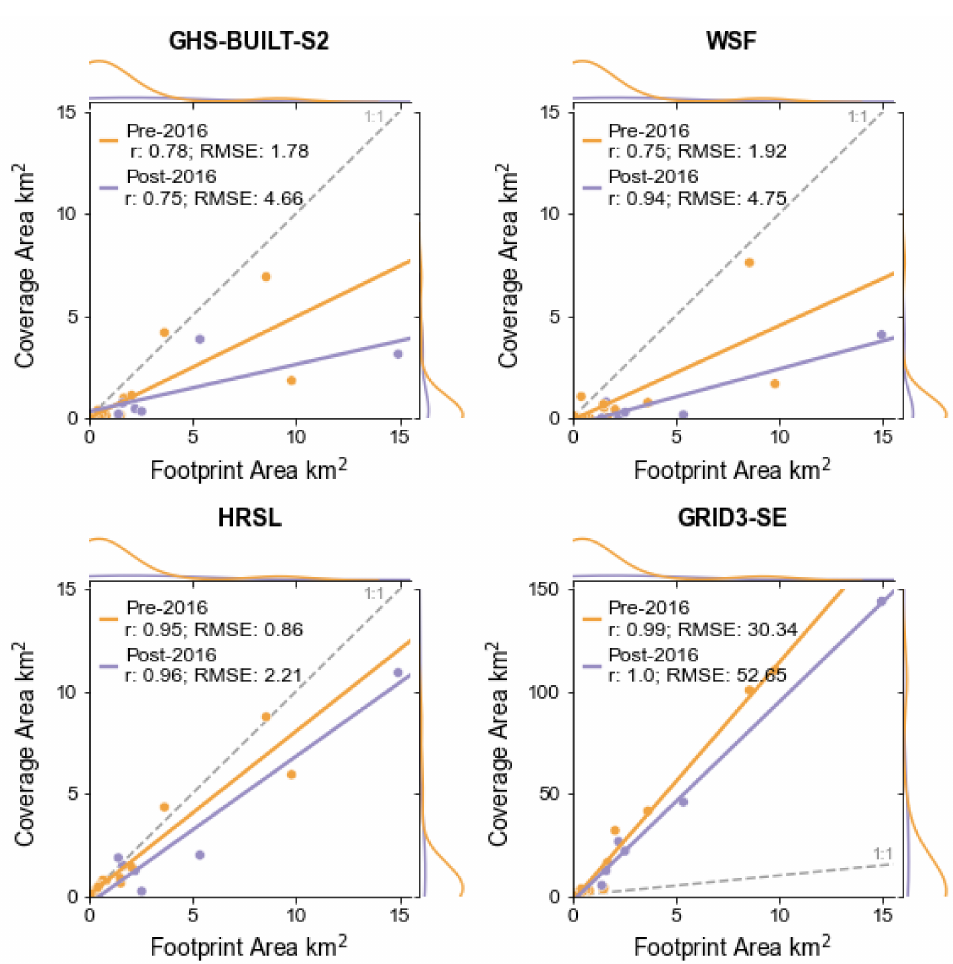
Figure 8. Scatterplots of human settlement product coverage compared to OSM–MS building footprint coverage for 30 study settlements. Orange and purple dots and lines of best fit represent pre-2016 and post-2016 settlements, respectively. Gray dashed line indicates a 1:1 agreement. GHS- BUILT-S2, Global Human Settlement Layer with Sentinel 2; WSF, World Settlement Footprint; HRSL, High Resolution Settlement Layer; GRID3-SE, Geo-Referenced Infrastructure and Demographic Data for Development settlement extent